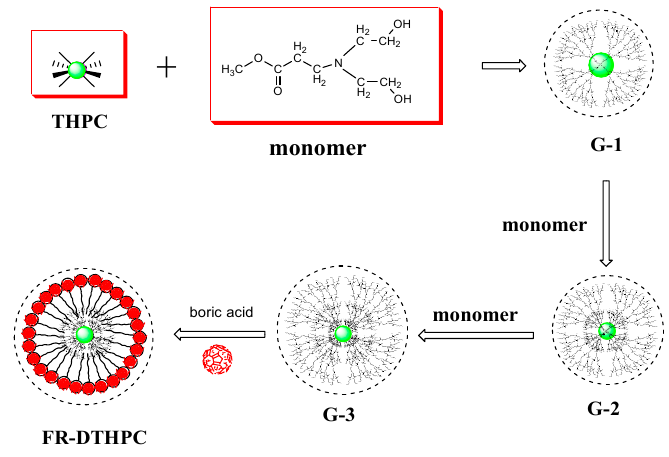
Figure 1. Mt and FR-DOMt ( a ) TGA, ( b ) XRD, ( c ) FTIR, ( d1 , d2 ) SEM.